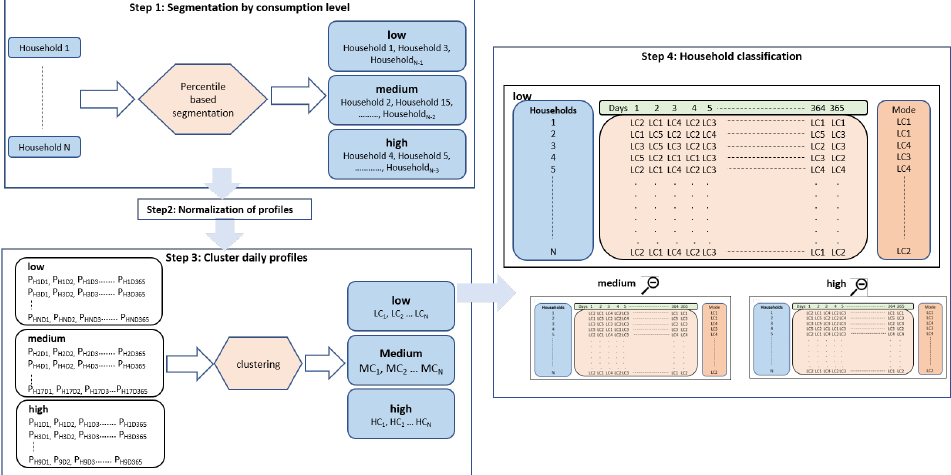
Figure 2. Methodological approach to electricity load profile characterisation through k-means clustering: Steps 1, 2, 3 and 4 are